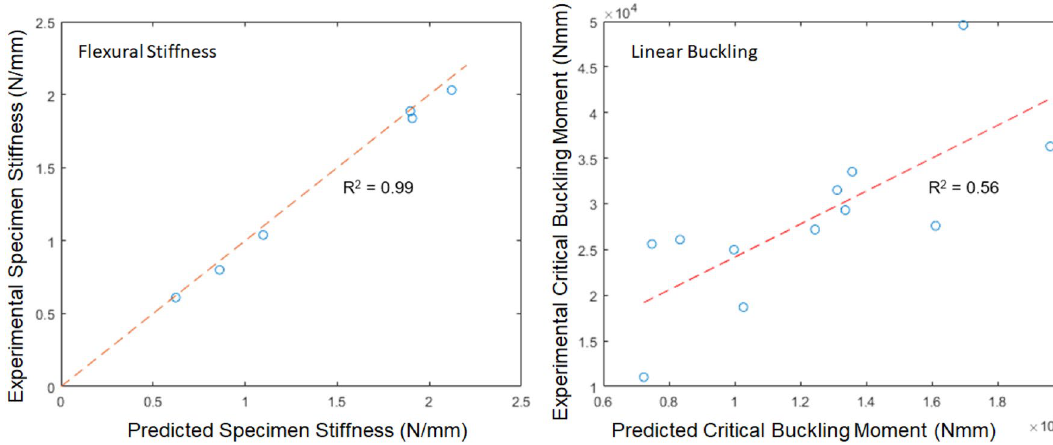
Figure 5. Model validation correlation plots, consisting of comparisons between predicted and measured values of flexural stiffness (left), and buckling load